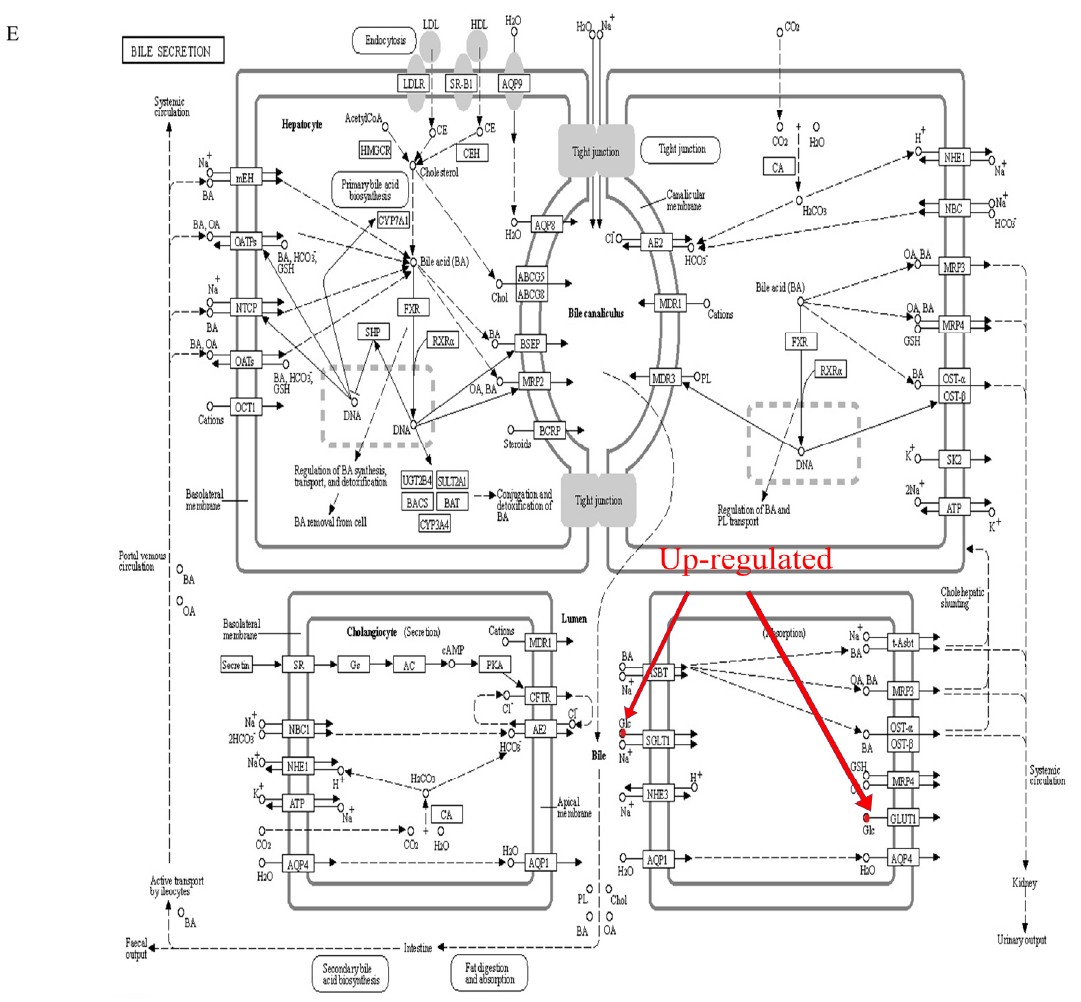
Figure 6. KEGG signal pathway analysis after treatment with LYCRPLs: ( A , B ) changes in rat fecal metabolites induced by high-fat diet in pyrimidine metabolism ( A ) and the TCA cycle ( B ); ( B , C ) changes in high-fat-diet rat fecal metabolites in the TCA cycle before ( B ) and after ( C ) treatment with LYCRPLs; ( D , E ) changes in high-fat-diet rat intestine D-glucose in terms of glycolysis ( D ) and bile secretion ( E ) after treatment with LYCRPLs. ( A – E ) The small circle represents metabolites, the red indicators represent up-regulation, and the blue ones represent down-regulation. The large squares represent other metabolic pathways, the small ones represent enzymes, and the small green ones represent enzymes unique to this species. The solid arrow indicates the reaction direction, and the dashed one indicates the relationship with other metabolic pathways.